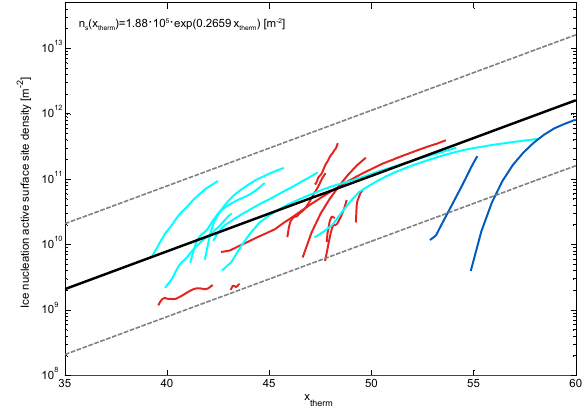
Figure 6. Ice nucleation active surface site densities as in Fig. 5 with exponential fit function (excluding the experiments starting at T start = 223K); the grey dashed lines indicate deviations from the fitting function by an order of